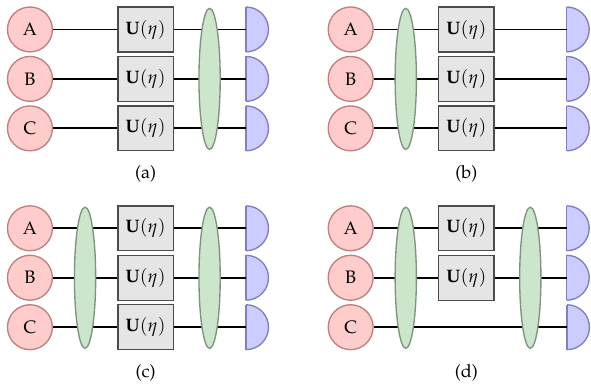
Figure 2. Different schemes depicting the use of quantum entanglement in quantum sensing and metrology experiments. Herein, the circle represents the probe state, the square represents the unitary evolution that encodes the unknown parameter η , the ellipse represents entangling operations, and the semicircle represents the measurement. ( a ) The quantum entanglement is only employed in the measurement, ( b ) the quantum entanglement is employed in the probe state, ( c ) both the probe state and measurement employ quantum entanglement, and ( d ) both the probe state and measurement employ quantum entanglement and the ancillary system is also included with